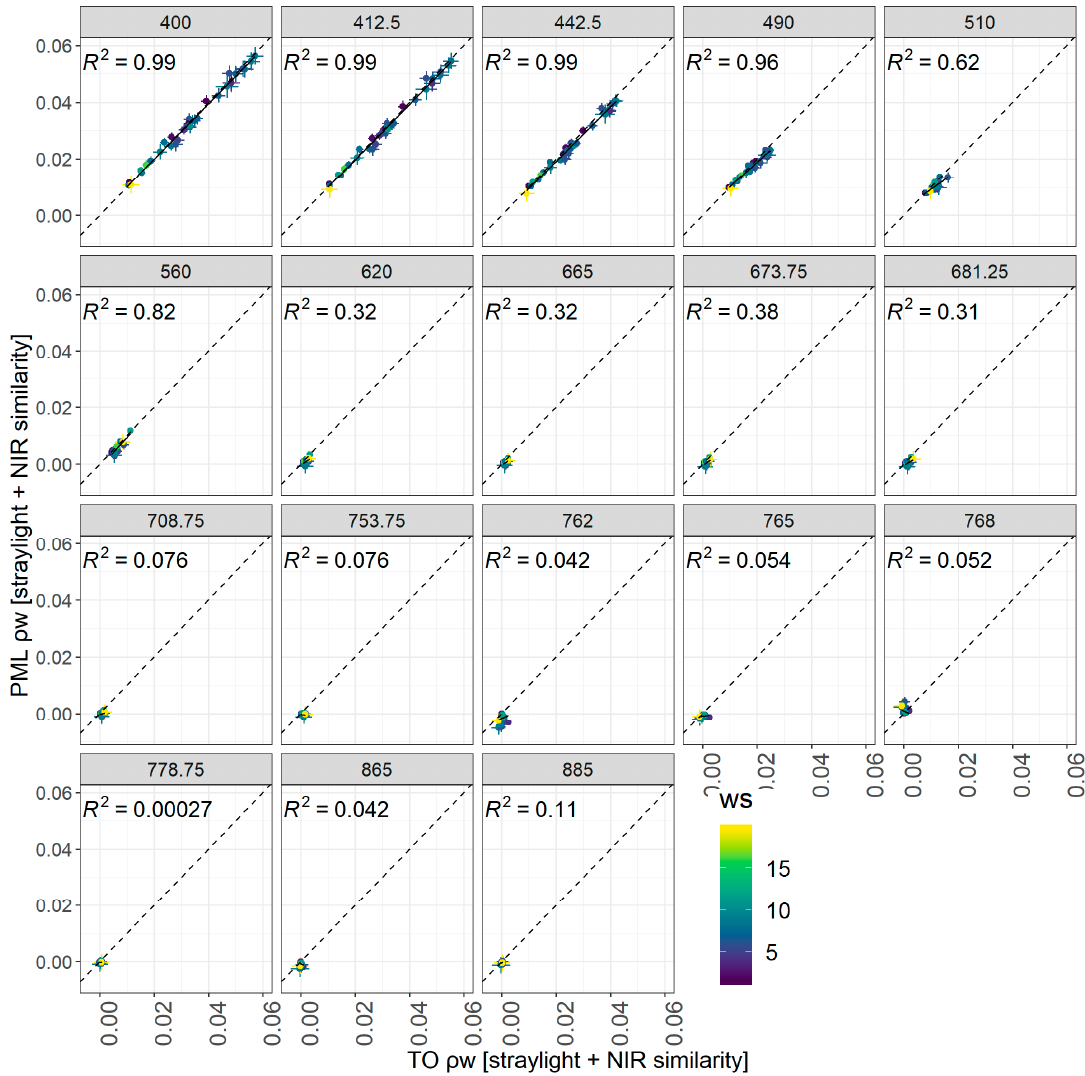
Figure A5. Comparison between TO and PML ρ w ( λ ) after straylight correction and NIR similarity Figure A5 . Comparison between TO and PML 𝜌 (cid:3050) (𝜆) after straylight correction and NIR similarity correction at OLCI’s correction at OLCI’s bands.